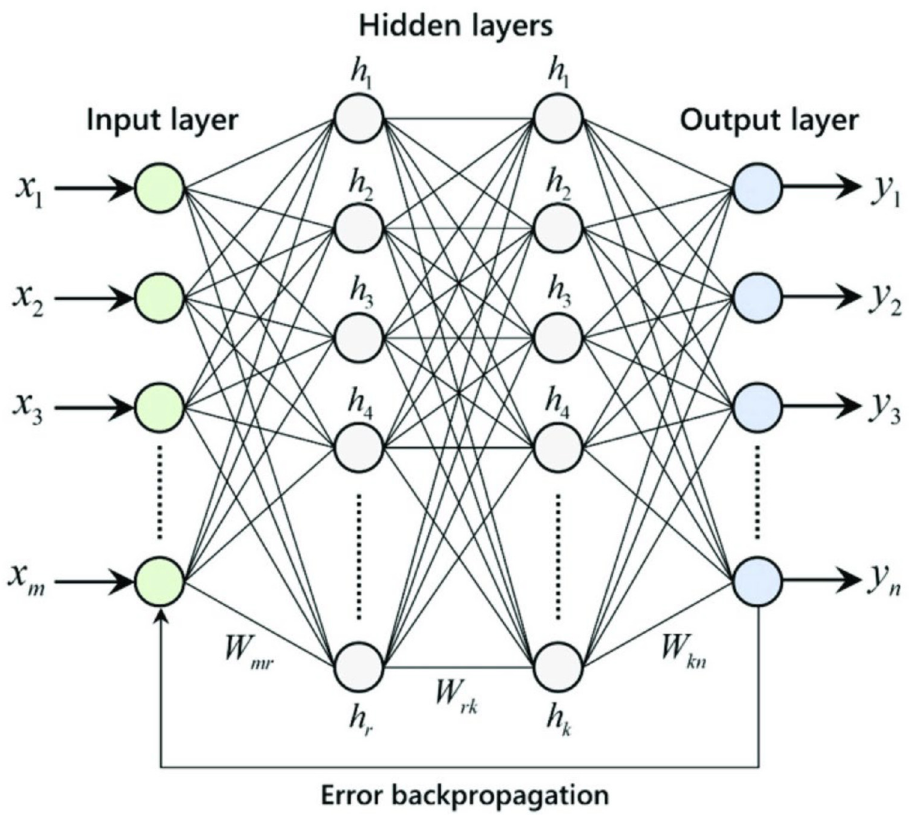
Figure 4. Schematic diagram of a multilayer feedforward network trained using the BP